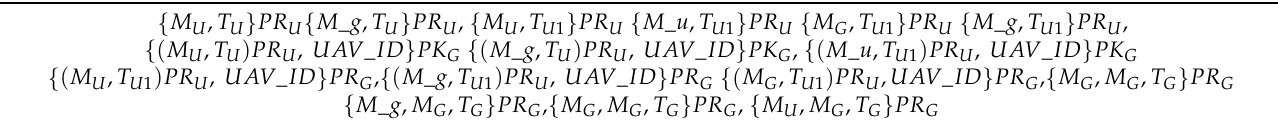
Table 8. Knowledge elements that attackers